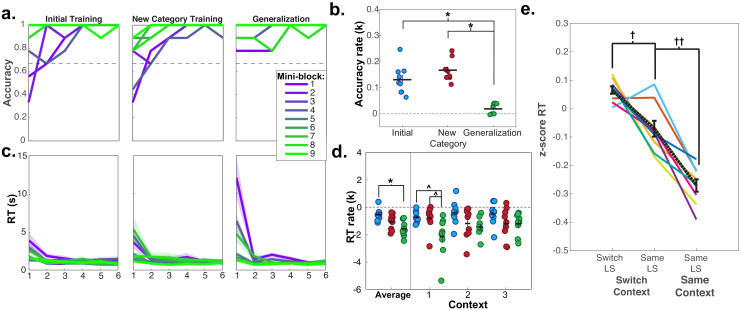
Learning curves and repetition effects from training and generalization phases for behavioral participants who passed the accuracy criterion for generalization in session 2 (N = 9).(a) Mean accuracy across participants for first six trials of the first nine mini-blocks of initial and new category training, as well as blocked generalization phase. Dashed line indicates chance-level performance. (b) Estimated exponential rate of change in mean accuracy in the first six trials for all mini-blocks in each phase, across participants. (c) Mean reaction times (RT) for each trial in each of the first nine mini-blocks for each of these phases. Shaded area represents standard error of the mean (SEM). Mean and standard error were calculated from the log-transformed RTs. (d) Estimated exponential rate of change in RT for first six trials within each phase for the first mini-blocks within the first three contexts in presentation order. For panels (b and d), each dot represents a single participant, and horizontal and vertical bars represent the mean and SEM, respectively. *p<0.05, Wilcoxon signed rank test, corrected for multiple comparisons, ^p<0.05, uncorrected. (e) RTs for trials from the pseudo-randomized generalization phase from sessions 2 and 3 where latent states remained the same or switched from the previous trial, while the context switched or stayed the same. RTs have been log-transformed and z-scored within session for each participant. Each line represents a participant, black dashed line indicates mean, and error bars indicate SEM. †p<0.05, ††p<0.01, repeated-measures t-test.